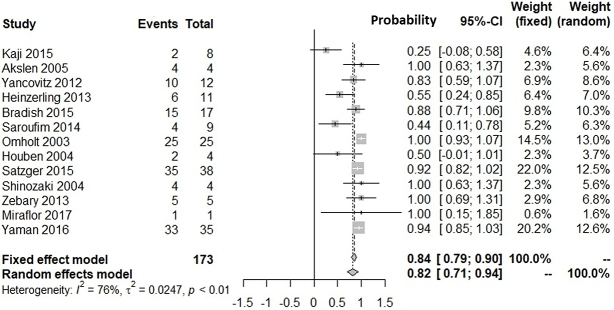
Probability of BRAFV600E (+) in metastatic lesions of melanoma against BRAFV600E (+) in primary lesions in pairwise comparisons.